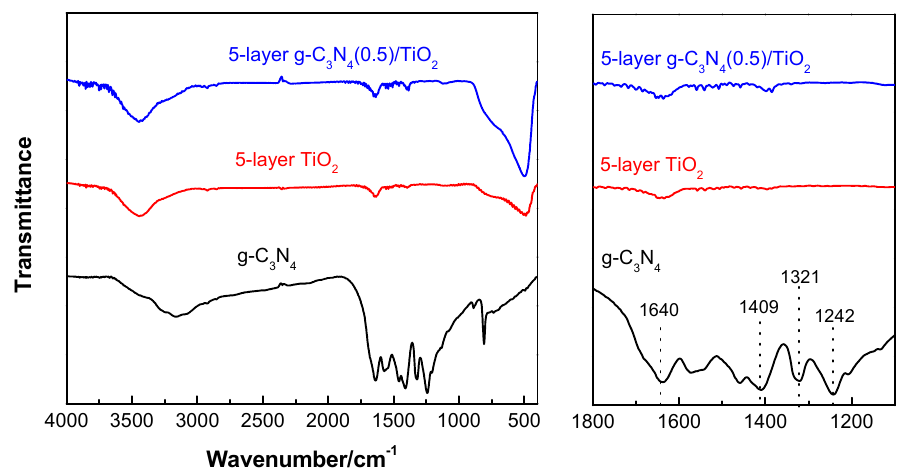
Figure 2. Fourier transform infrared (FT-IR) spectrum of g-C 3 N 4 , 5-layer TiO 2 , 5-layer g-C 3 N 4 (0.5)/TiO 2.